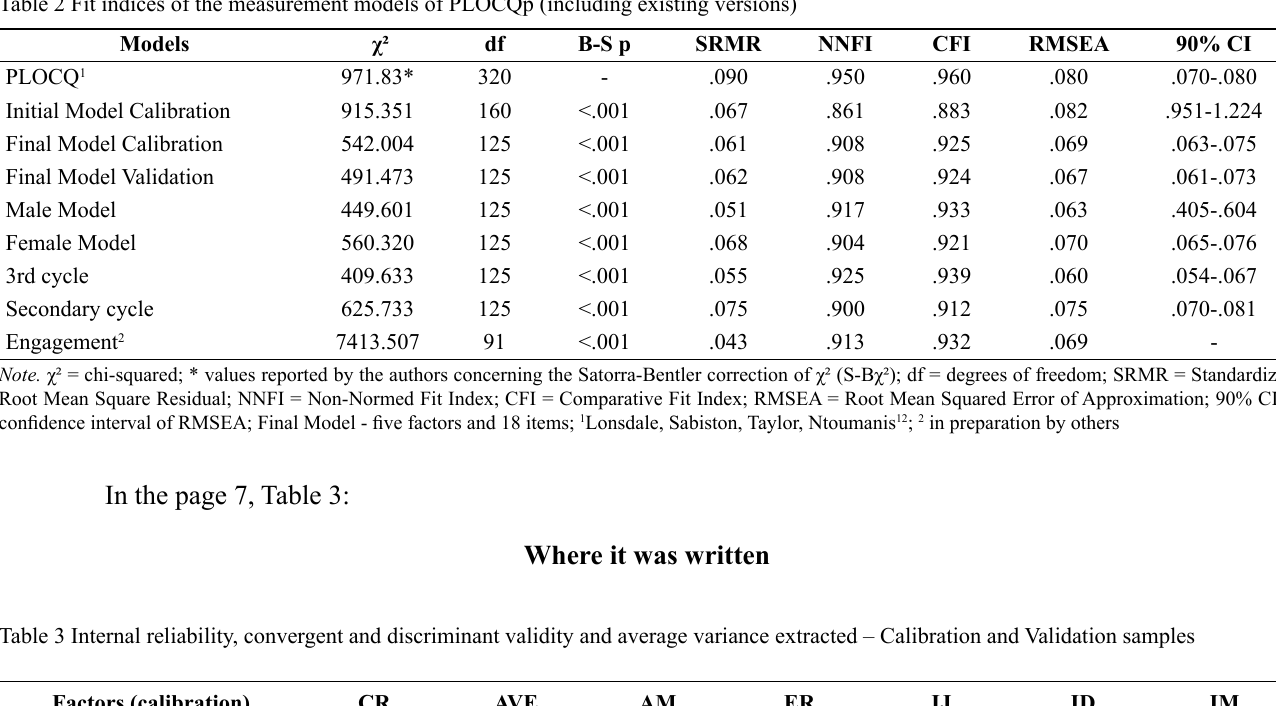
Table 2 Fit indices of the measurement models of PLOCQp (including existing versions) Models PLOCQ 1 Initial Model Calibration Final Model Calibration